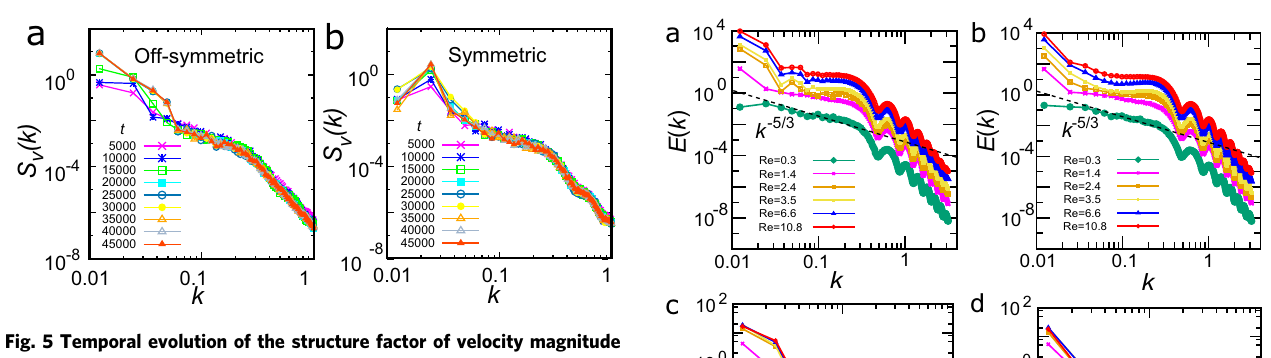
Fig. 5 Temporal evolution of the structure factor of velocity magnitude S v ( k ). a For an off-symmetric composition (OSM) ( Φ = 0.3, Re = 10.8) with the nonlinear term. b For a symmetric composition (SM) ( Φ = 0.5, Re = 10.8) with the nonlinear term. S ( k ) (see Fig. 4c and d) for particle distributions while